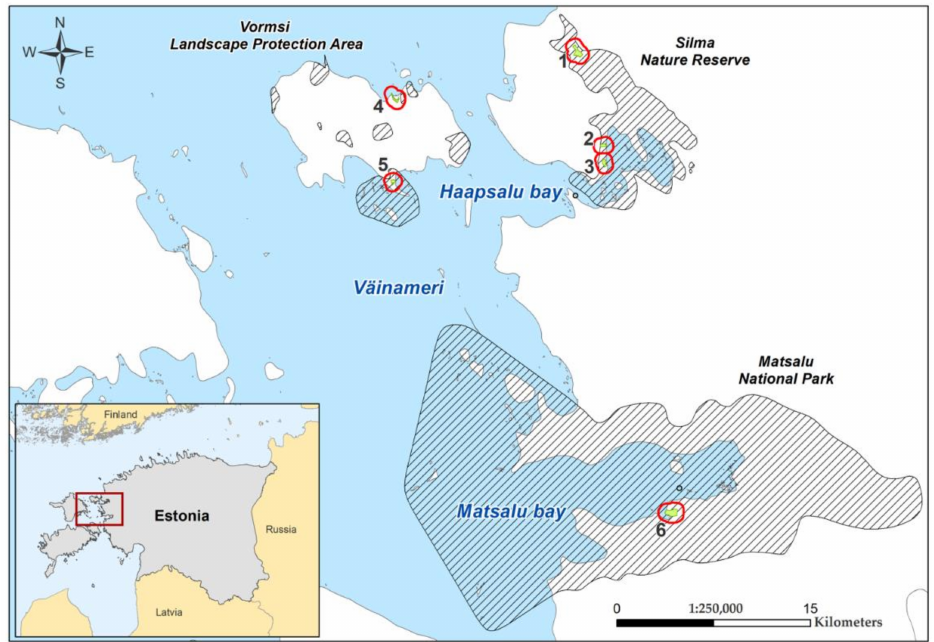
Figure 1. Study sites in western Estonia. 1. Kudani, 2. Tahu North, 3. Tahu South within Silma Nature Reserve; 4. Ralby, 5. Rumpo East within Vormsi Landscape Protection Area and 6. Matsalu02 within the Matsalu National